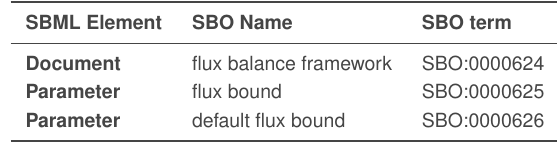
Table 3: SBML components and the additional types of SBO terms specified in the Flux Balance Constraints package that may be assigned to them. Note that the important aspect here is the set of specific SBO identifiers, not the SBO term names, because the names may change as SBO continues to evolve. See the text and SBO online resources for detailed descriptions on the meaning and usage of these terms.